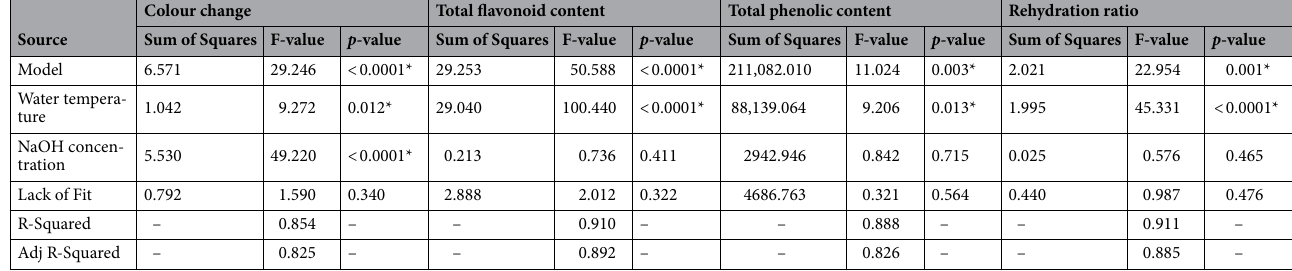
Table 1. Regression summary and ANOVA for quality parameters for RW-dried black carrot puree.